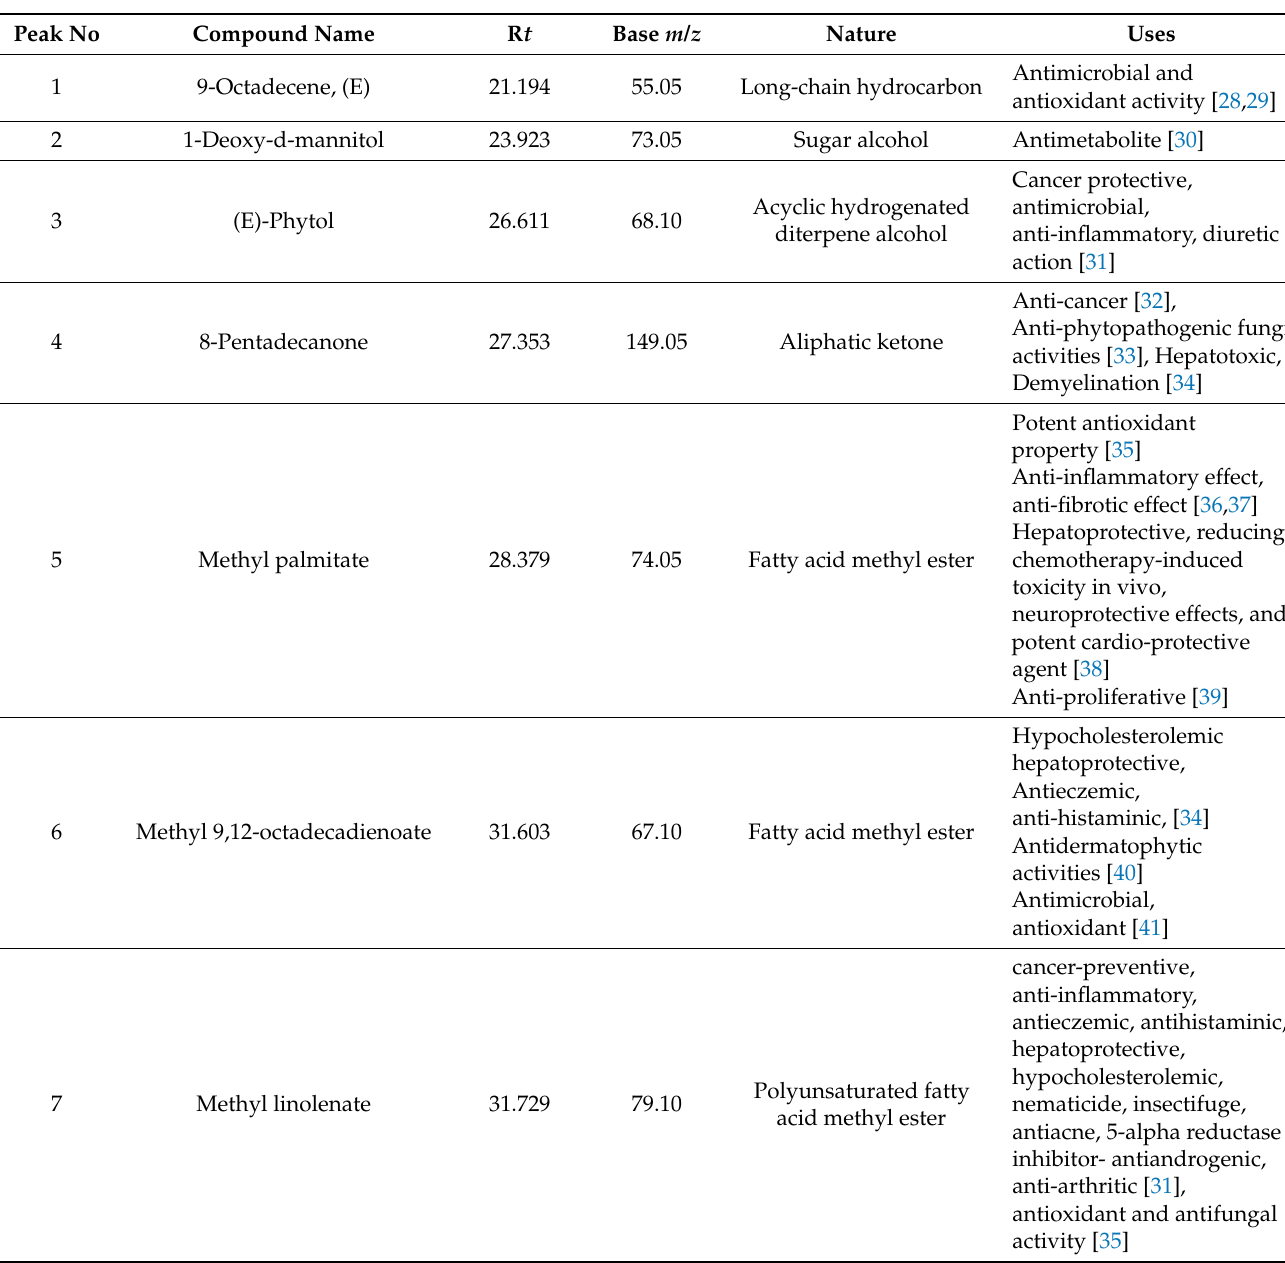
Table 5. GC–MS-identified compounds of methanol extract of T. terrestris